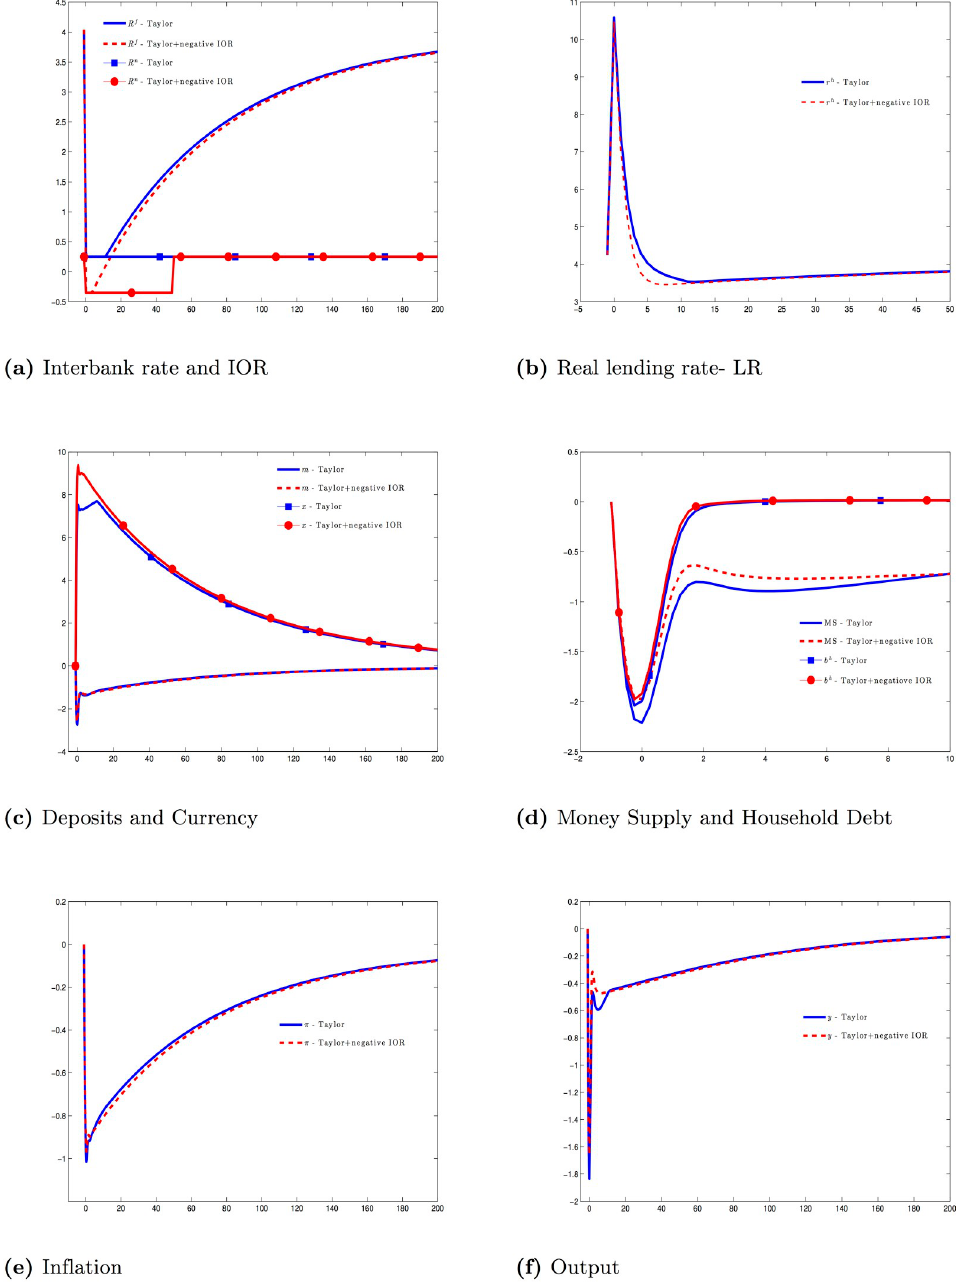
Fig 2. Financial crisis under Taylor rule (M2) and negative IOR (M3).